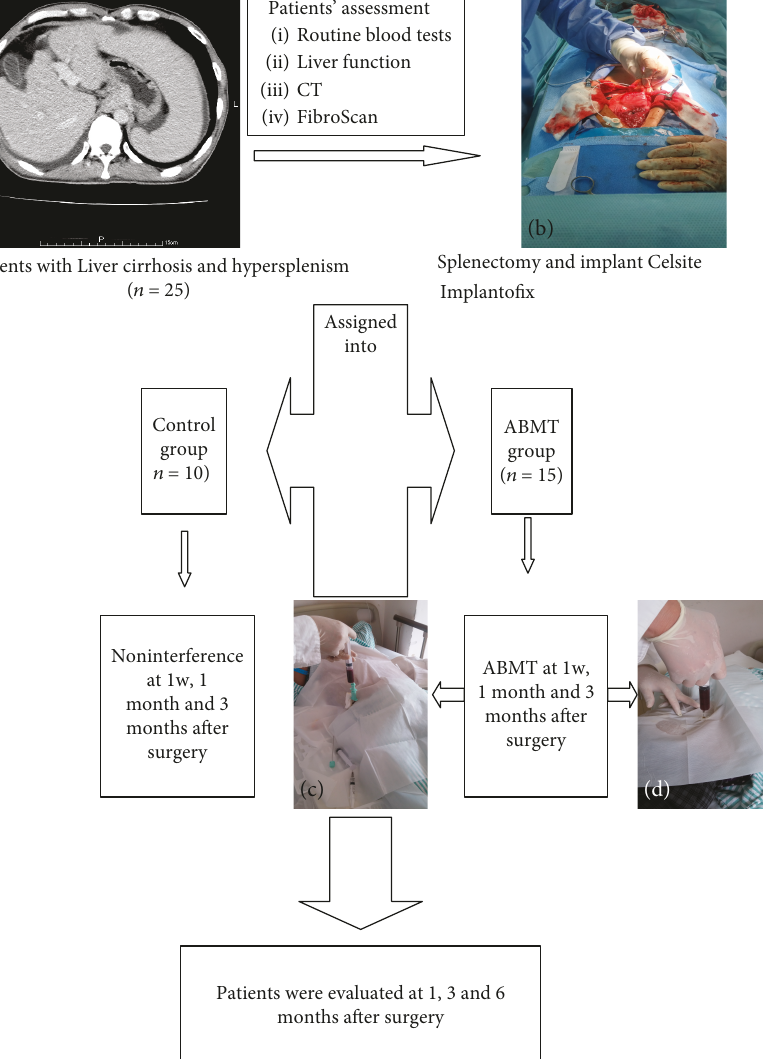
Figure 1: Flowchart of the study design. Representative images during the procedure are shown: (a) CT manifestations in patients with liver cirrhosis ( n = 25 ), (b) splenectomy and implant using Celsite Implanto fi x ( n = 25 ), (c) bone marrow extraction from the anterior superior iliac spine ( n = 15 ), (d) ABMT ( n = 15